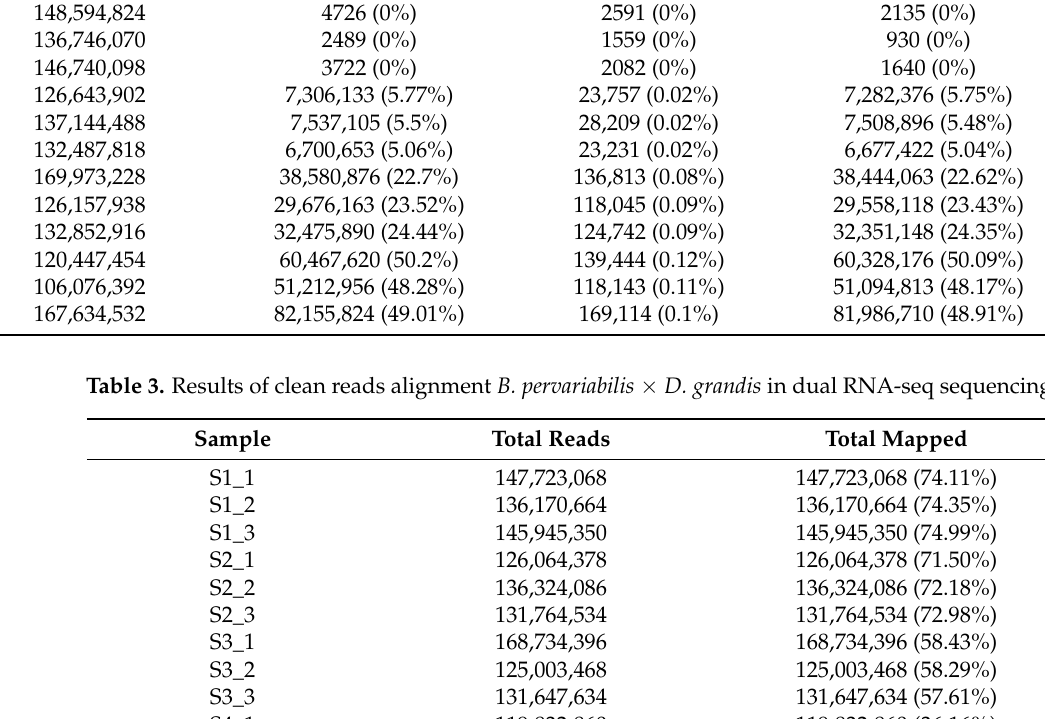
Table 2. The results of clean reads alignment A. phaeospermum genome in dual RNA-seq sequencing. Sample